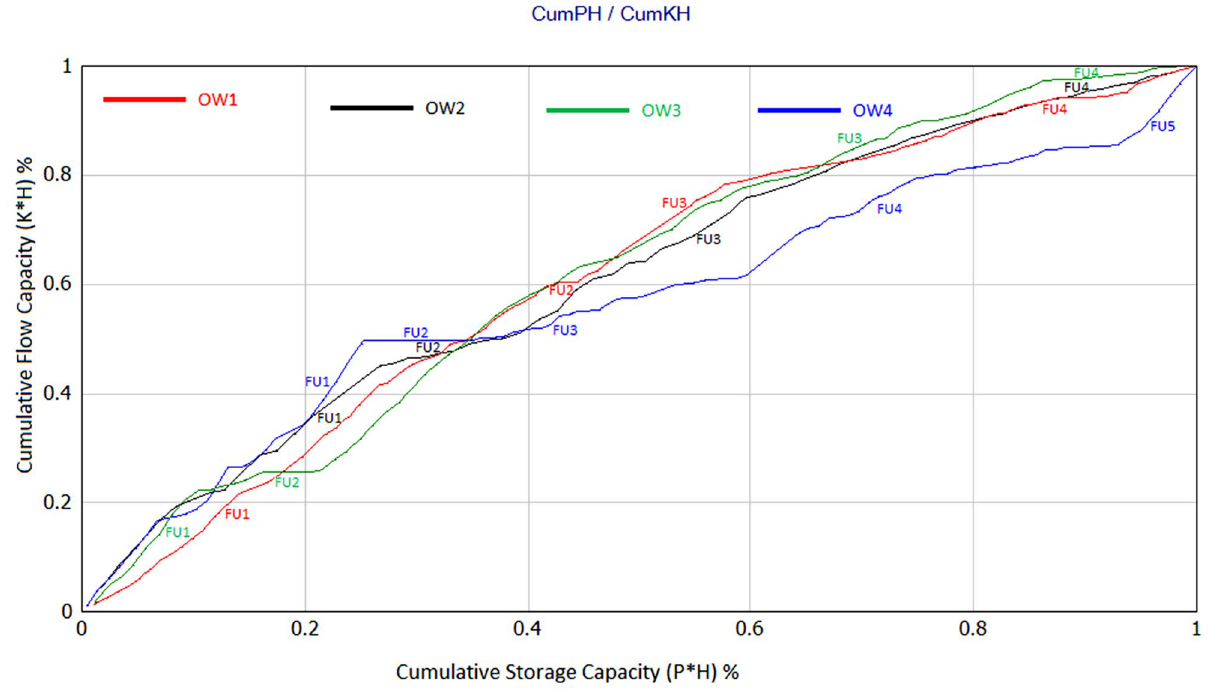
Figure 8. Stratigraphic modified Lorenz plots (SMPLs) for the studied wells showing different flow units (FUs).